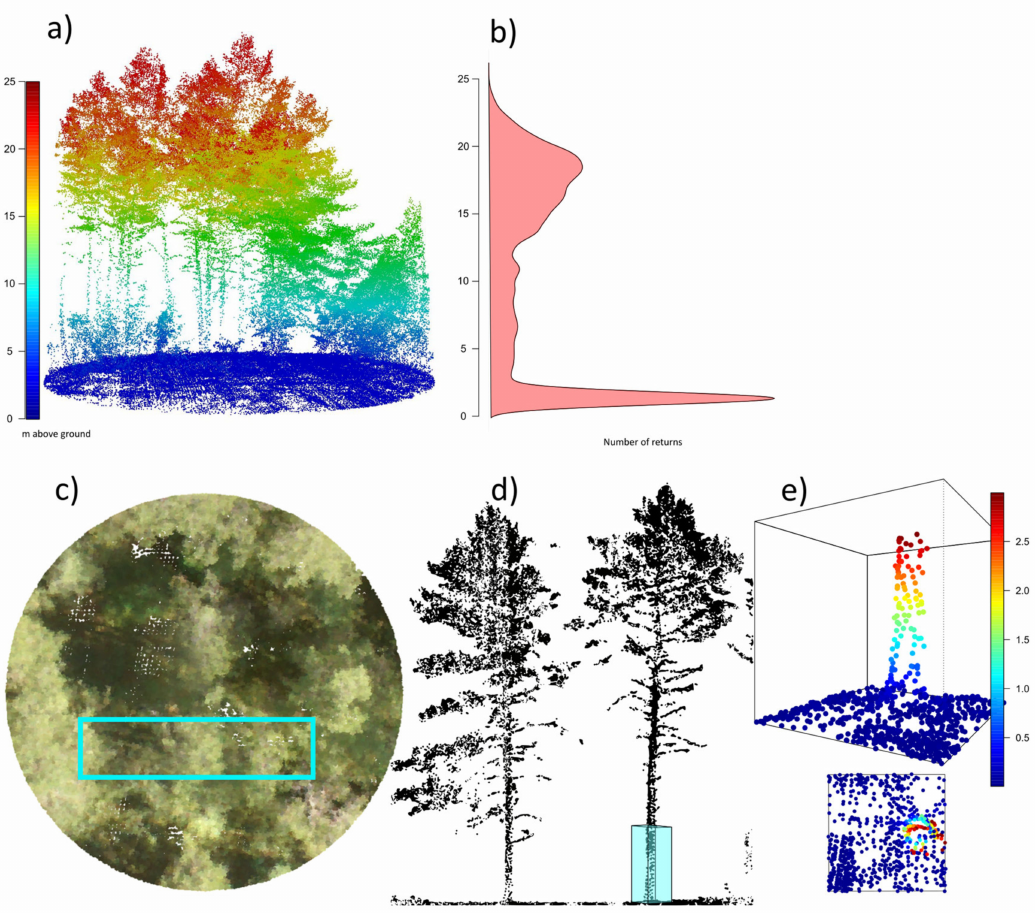
Figure 2. Graphical overview of the laser scanning data from unmanned aerial vehicle (UAV-LS) data: ( a ) 2D representation of the 3D point cloud for one field plot, ( b ) point density distribution along the vertical profile, ( c ) vertical view of the coloured laser scanning point cloud using the RGB images, ( d ) cross-section of the point cloud and e) detail on one of the tree